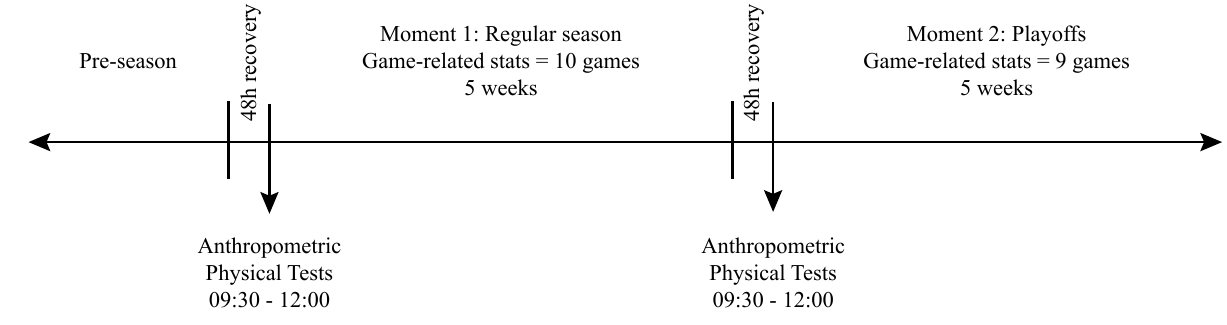
Figure I – Timeline of the moments of